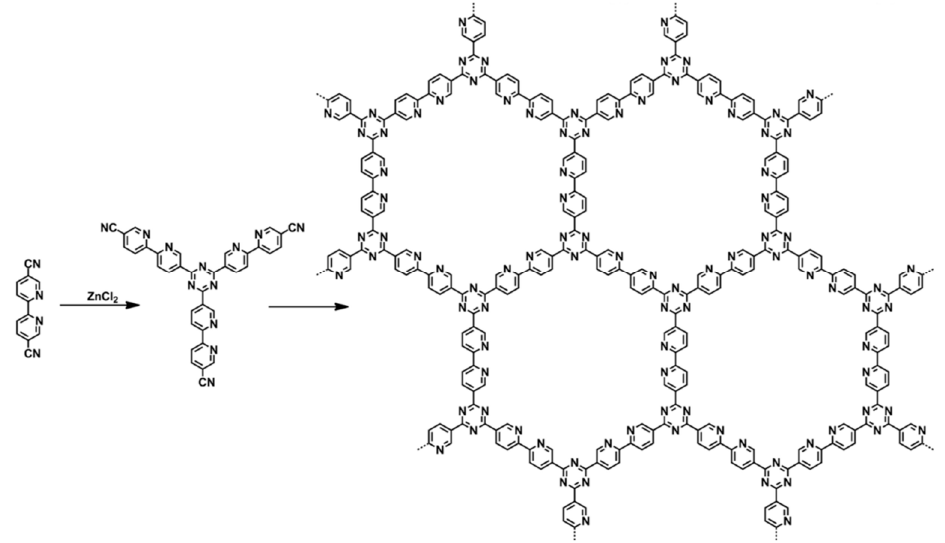
Figure 5. ( Left ) Representation of the coating procedure step. ( Right ) SEM micrograph of ( A ) CTF powders ( B–E ), CTF-coated monolith ( F ) view on the wall of a CTF-coated monolith (Adapted with permission from [45]. Copyright 2017, American Chemical Society).